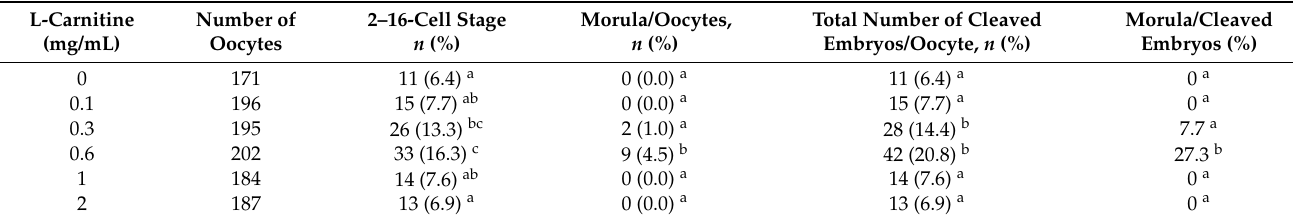
Table 3. Effects of L-Carnitine supplementation during IVM on preimplantation embryo development of canine oocytes following IVF and IVC ( n =